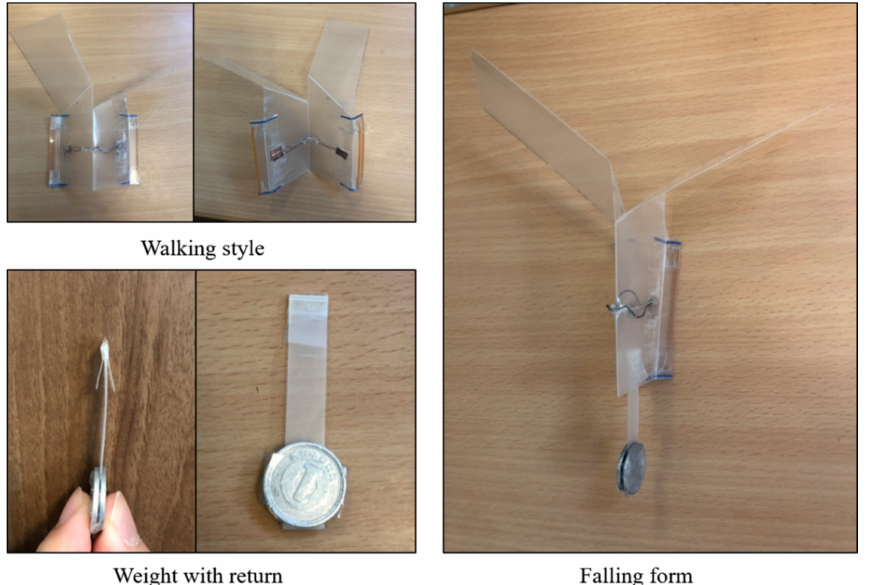
Figure 16. Overview of the developed sheet type